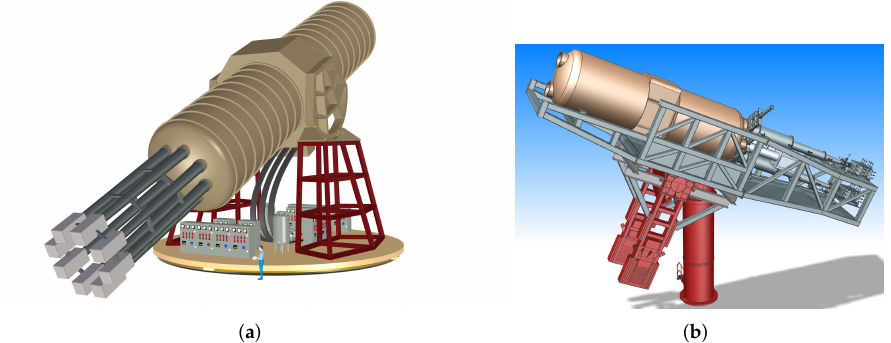
Figure 4. ( a ) Sketch of IAXO: The 20m-long magnet features 8 bores with a 60-cm diameter. Each bore will be equipped with an X-ray focusing device and low-background detectors, which, as indicated, will have an appropriate shielding. The moving platform will permit following the centre of the sun for 12 h a day. ( b ) The 10m-long BabyIAXO magnet will also be tracking the sun for approx. 12 h a day. It will have two 70-cm diametre bores, to which two different telescopes will be